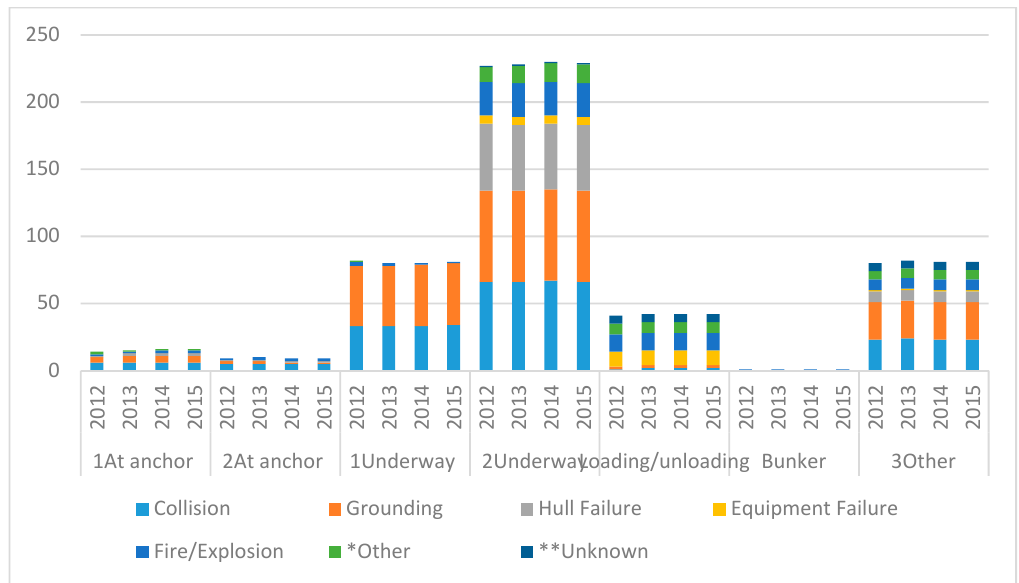
Table 9. Statistics for oil spills over 700 tons from 2012 to 2015.